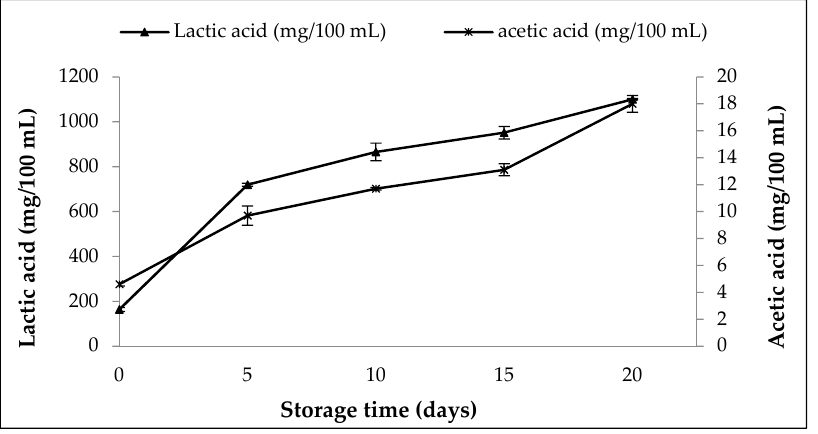
Figure 4. Changes in the content of lactic and acetic acids in SOFB during storage at 4 °C for 20 days.